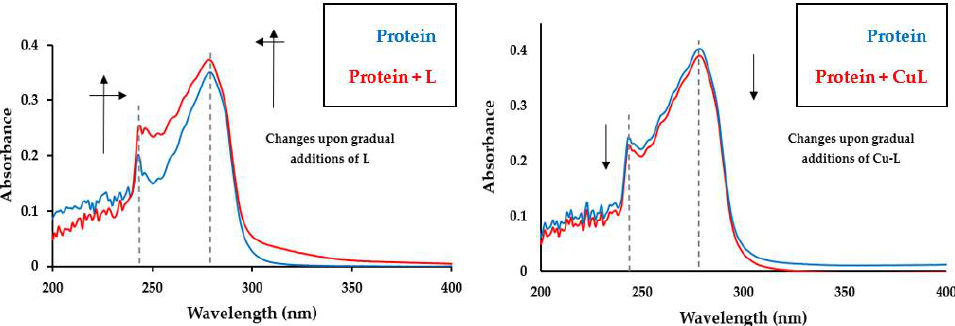
Figure 3. Changes in the absorption spectrum of HSA upon titration with L ( left ) and Cu-L ( right )